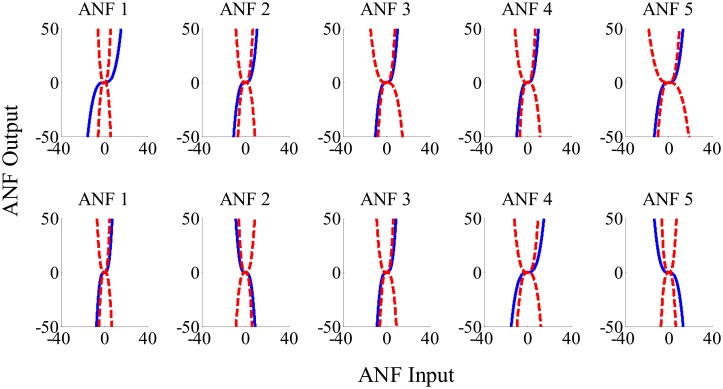
The ensemble averages of estimated cubic ANFs along with their standard deviation bounds for the T7–P7 (top panels) and Fp1–F3 (bottom panels) for the interictal states of the training data set.The solid lines represent means and dotted lines represent standard deviation bounds. Coefficients of cubic ANFs were utilized to determine the mean and standard deviation bounds. ANFs, associated nonlinear functions.